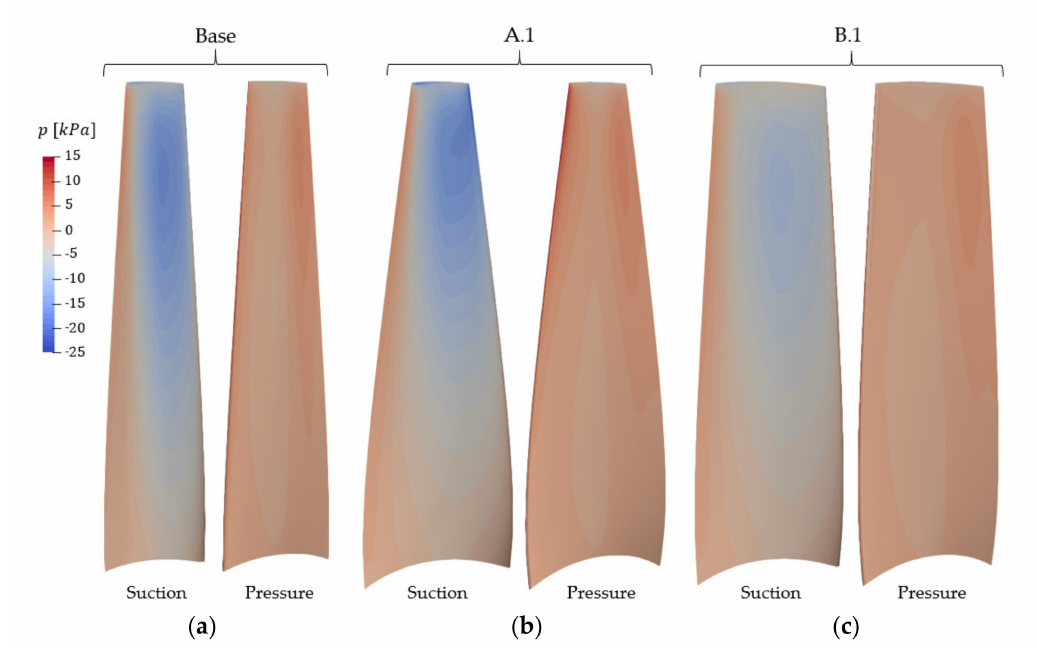
Figure 8. Pressures distribution on blade suction and pressure sides: ( a ) Initial geometry; ( b ) optimized geometry A.1; ( c ) optimized geometry